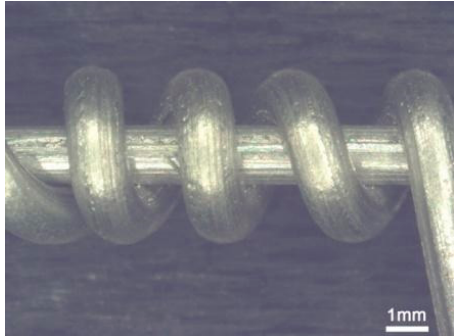
Figure 6. 0.25 wt.% MoB 2 .